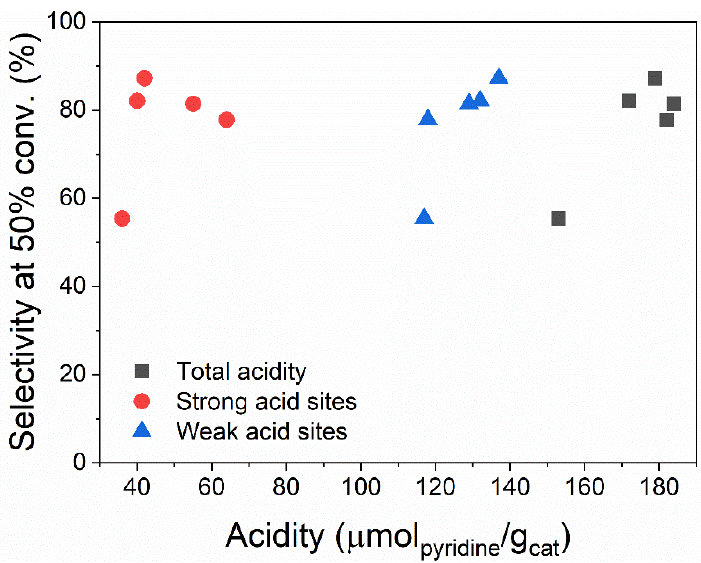
Figure 7. Dependence of selectivity at 50% conversion on the strength of acid sites.